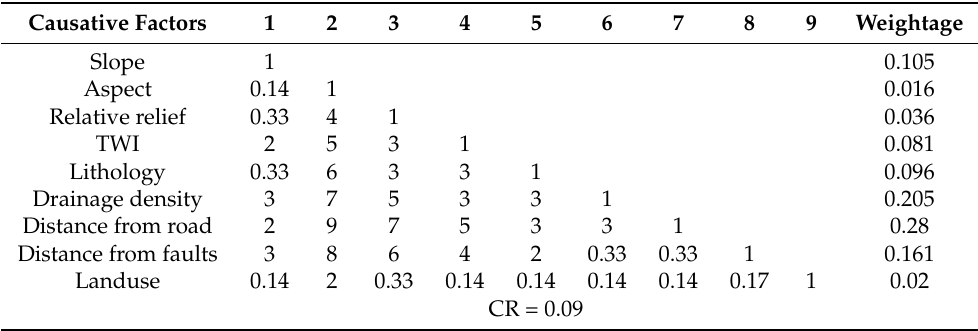
Table 3. AHP weightage for causative factors.